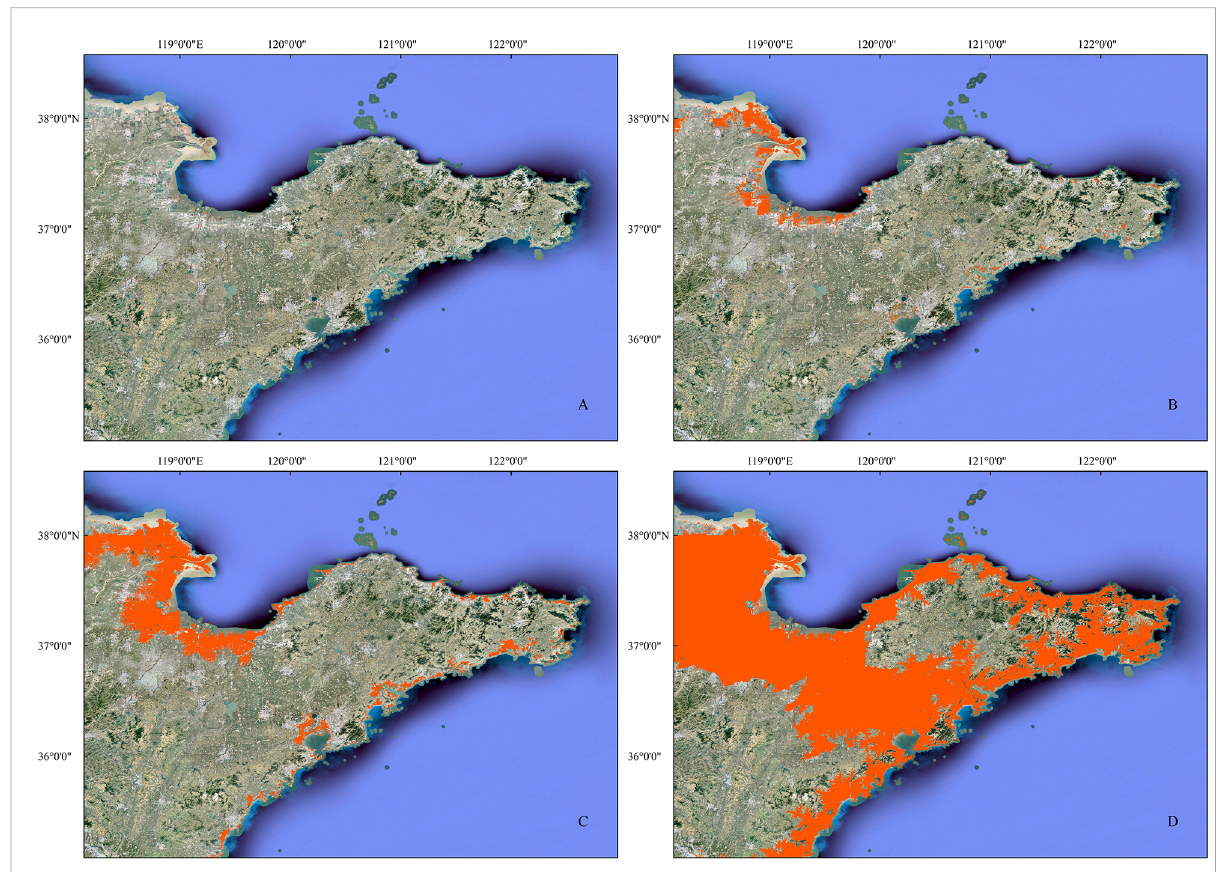
FIGURE 12 The areas of the Shandong Peninsula that will be submerged due to sea level rise (A) : 2050; (B) : 2100; (C) : 2150; and (D) : after all ice caps were